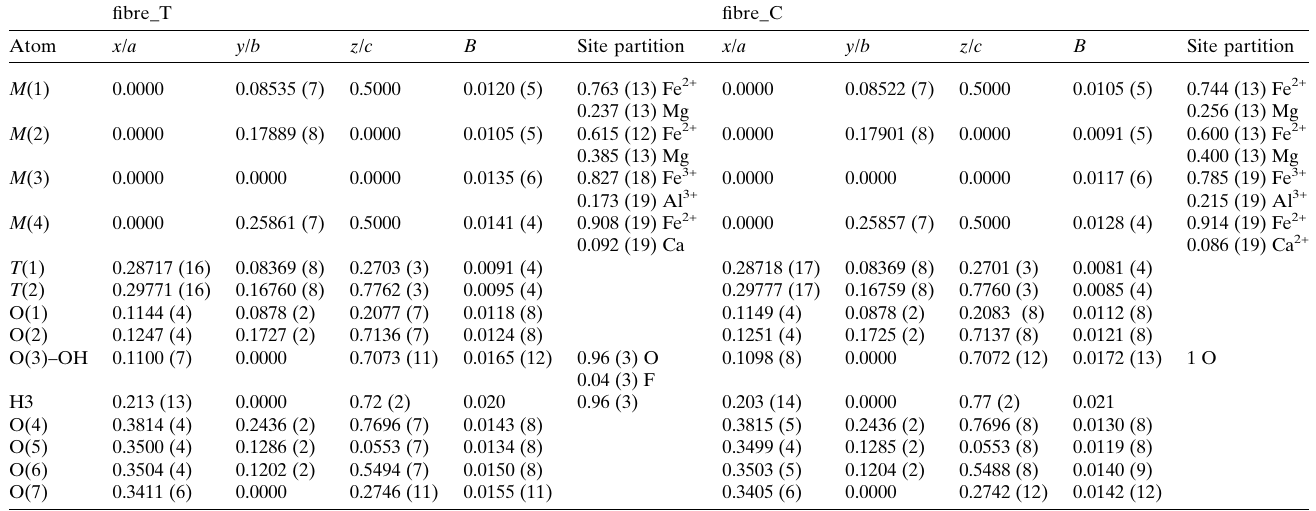
Table 2 Final atomic coordinates, occupancies, and atomic displacement parameters (A˚ 2 ) for fibre_T and fibre_C. fibre_T fibre_C